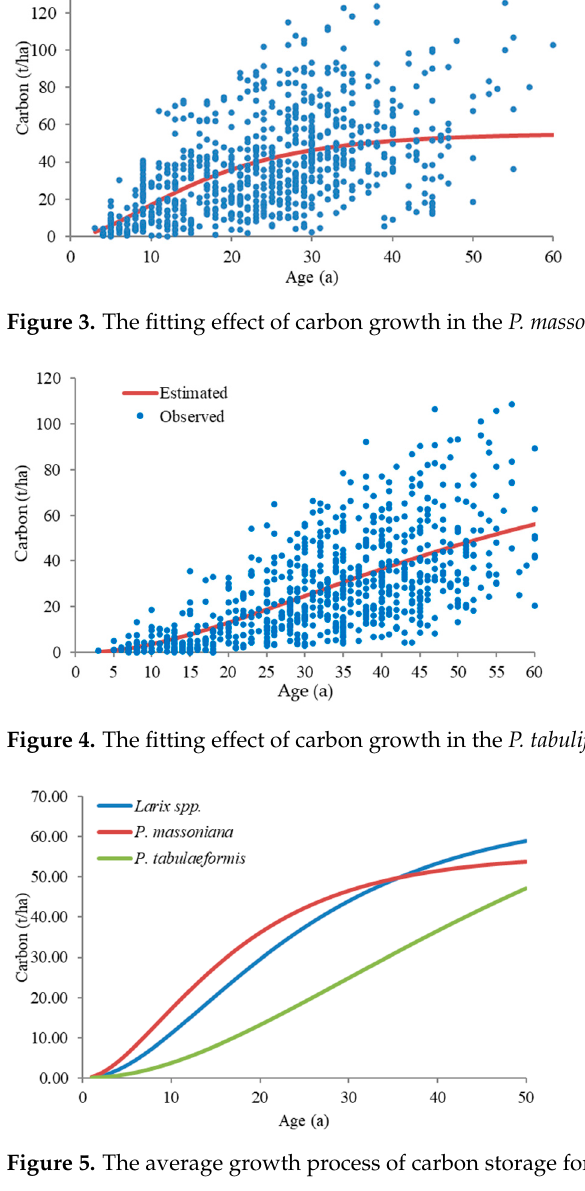
Figure 5. The average growth process of carbon storage for the three plantations.